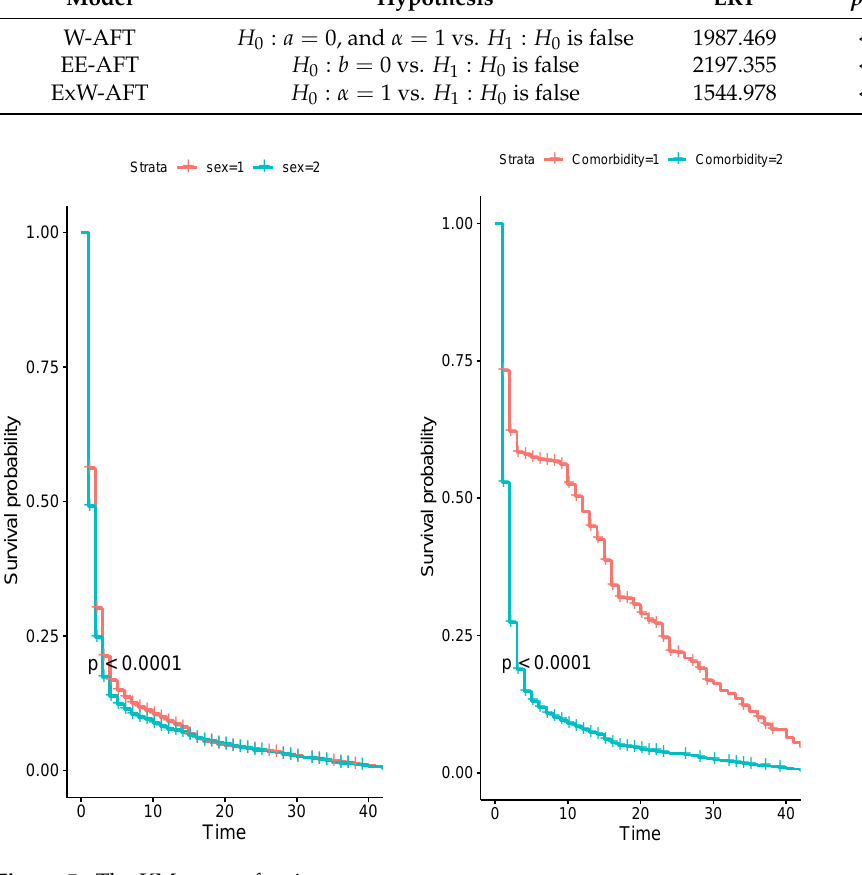
Figure 5. The KM curves for